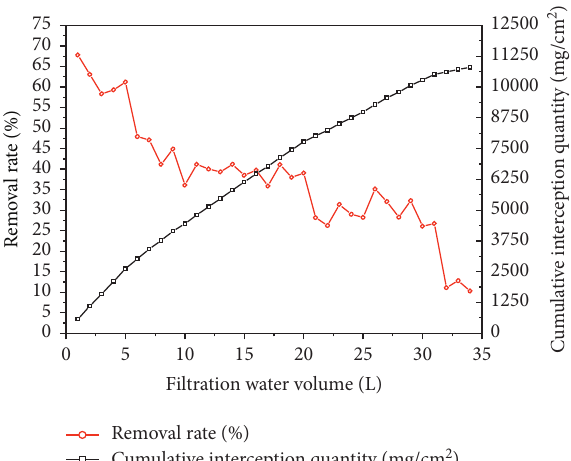
Figure 8: The relationship between the filtration volume and the removal rate and cumulative interception quantity.